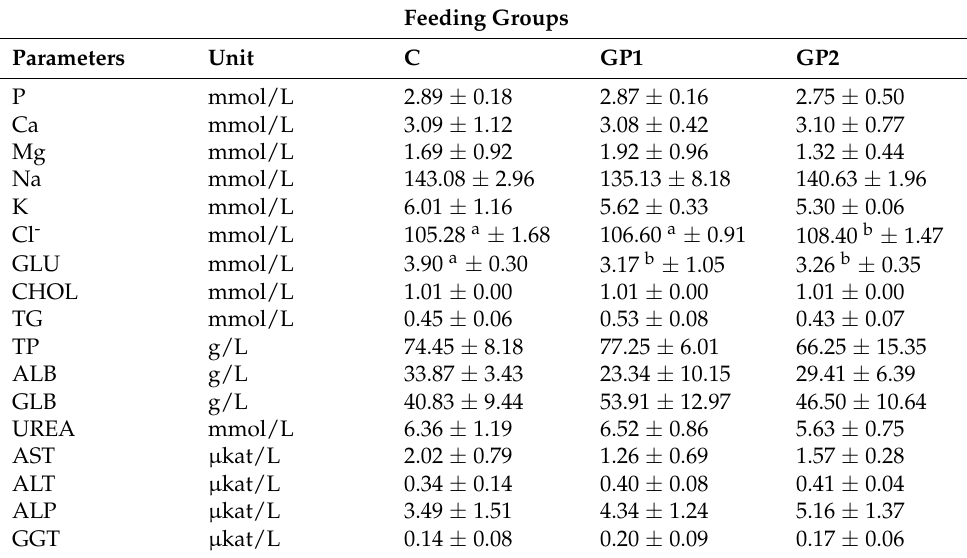
Table 5. Biochemical wether blood parameters.